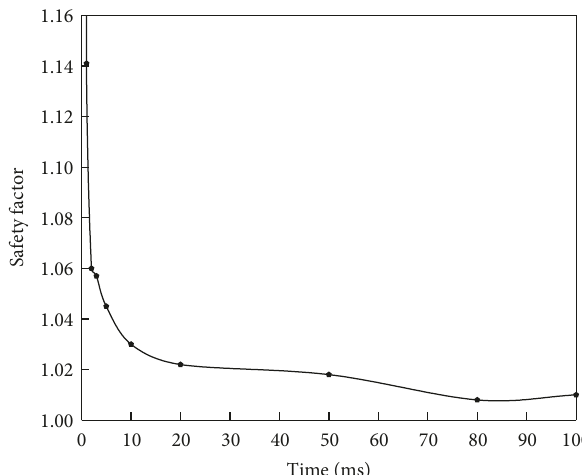
Figure 18: Curve of the safety factor during the entire process of simultaneous